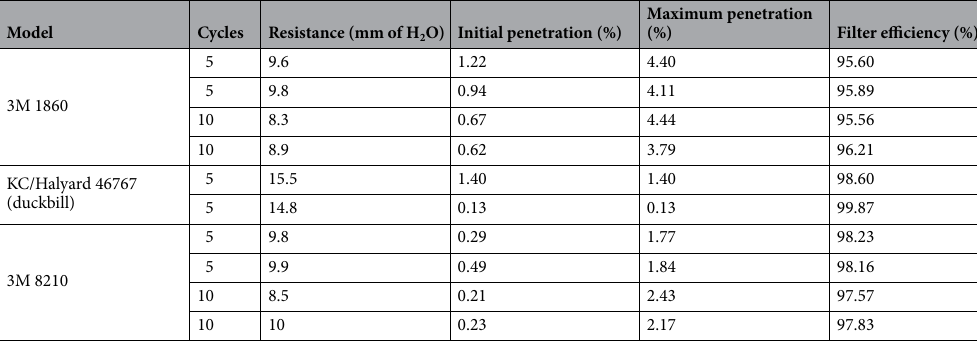
Table 4. Results from ICS Laboratories on full loading filtration efficiency according to NIOSH standard Procedure No. TEB-APR-STP-0059. Each row represents data from a single measurement on a single N95